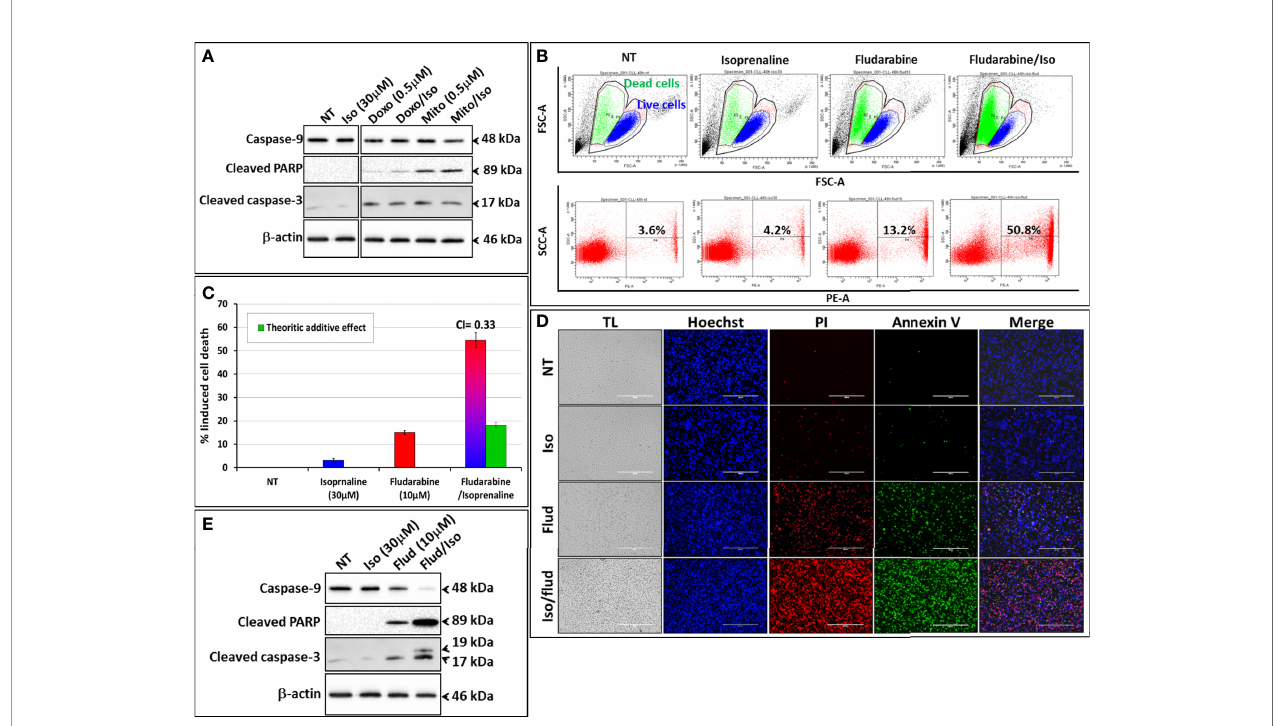
FIGURE 5 | Isoprenaline potentiates fl udarabine effect to synergistically induce apoptotic cell death in CLL primary cells. CPCs were pre-treated with Isoprenaline (30 m M) for 12h, to allow intracellular ATP depletion, prior to the addition of the second drug of the combination. (A) Effect of the combinatorial treatment of Isoprenaline with different anthracyclines (Doxorubicin and Mitoxantrone) on CPCs. Cytotoxic effects of the different treatment were assessed through the quanti fi cation of apoptotic cell death markers (caspase-3, -9 and cleaved PARP). All cut and reassembled bands belong to the same blot-images (see Supplementary Figure 8 for original blot images). (B) Cytotoxicity/cell-growth inhibition of primary CLL cells by the purine analogue fl udarabine (10 m M) alone or in combination with Isoprenaline (30µM). Induced cell death was assessed by PI staining followed by fl ow cytometry analysis. (C) Average cytotoxic effect of Isoprenaline/Fludarabine combination on leukemic cells isolated from 5 CLL patients. The Cooperation Index (CI) between Isoprenaline and fl udarabine was calculated, and was far below 1 indicating a high synergism between these two drugs. (D) Fluorescent microscopic images showing CPCs treated with fl udarabine (10 m M) alone or in combination with Isoprenaline (30 m M). The cells were stained with Hoechst (blue), AnnexinV (green), PI (red). (E) Assessment of Isoprenaline/ fl udarabine combination on apoptotic cell-death markers (caspase-3, -9 and PARP) in CPCs. Full-length blots/gels are presented in Supplementary Figure 8